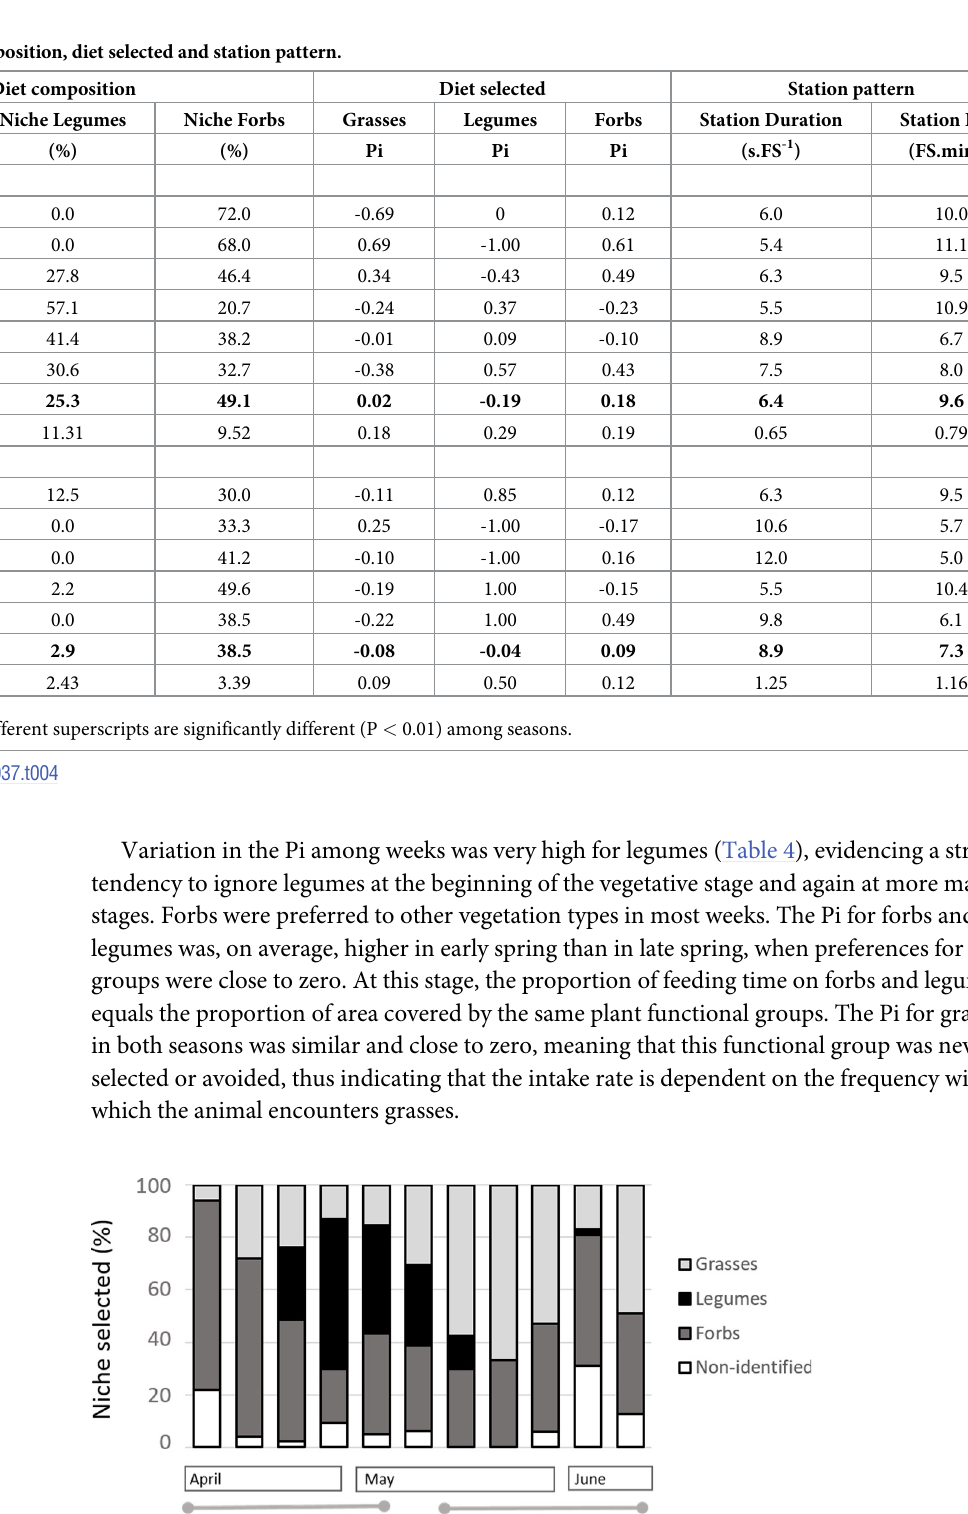
Fig 8. Weekly pattern of diet composition at major meals. Diet estimated from type of feeding niche selected. (n = 5).